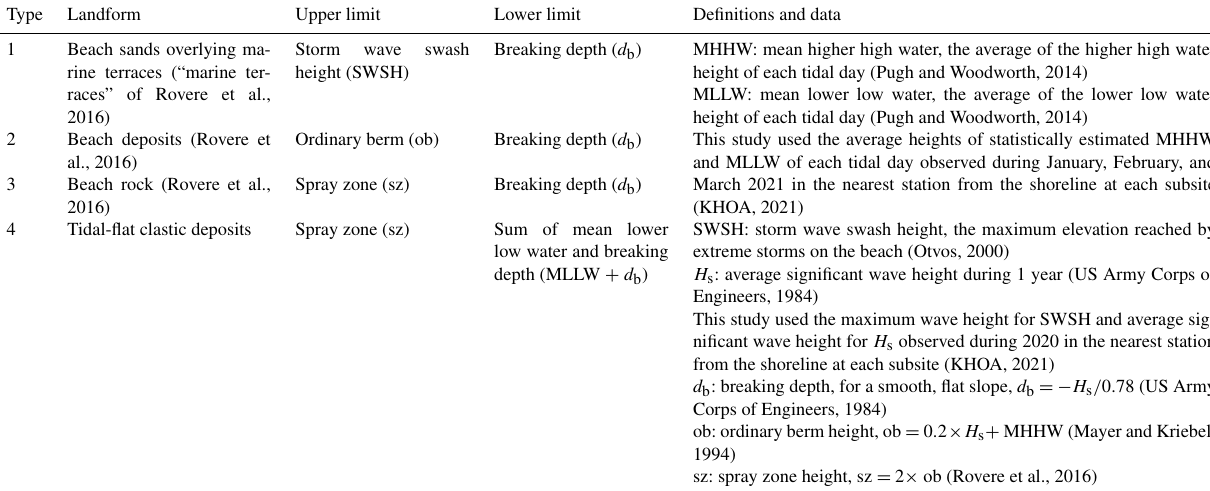
Table 1. Landforms used for calculating paleo-relative sea level in this